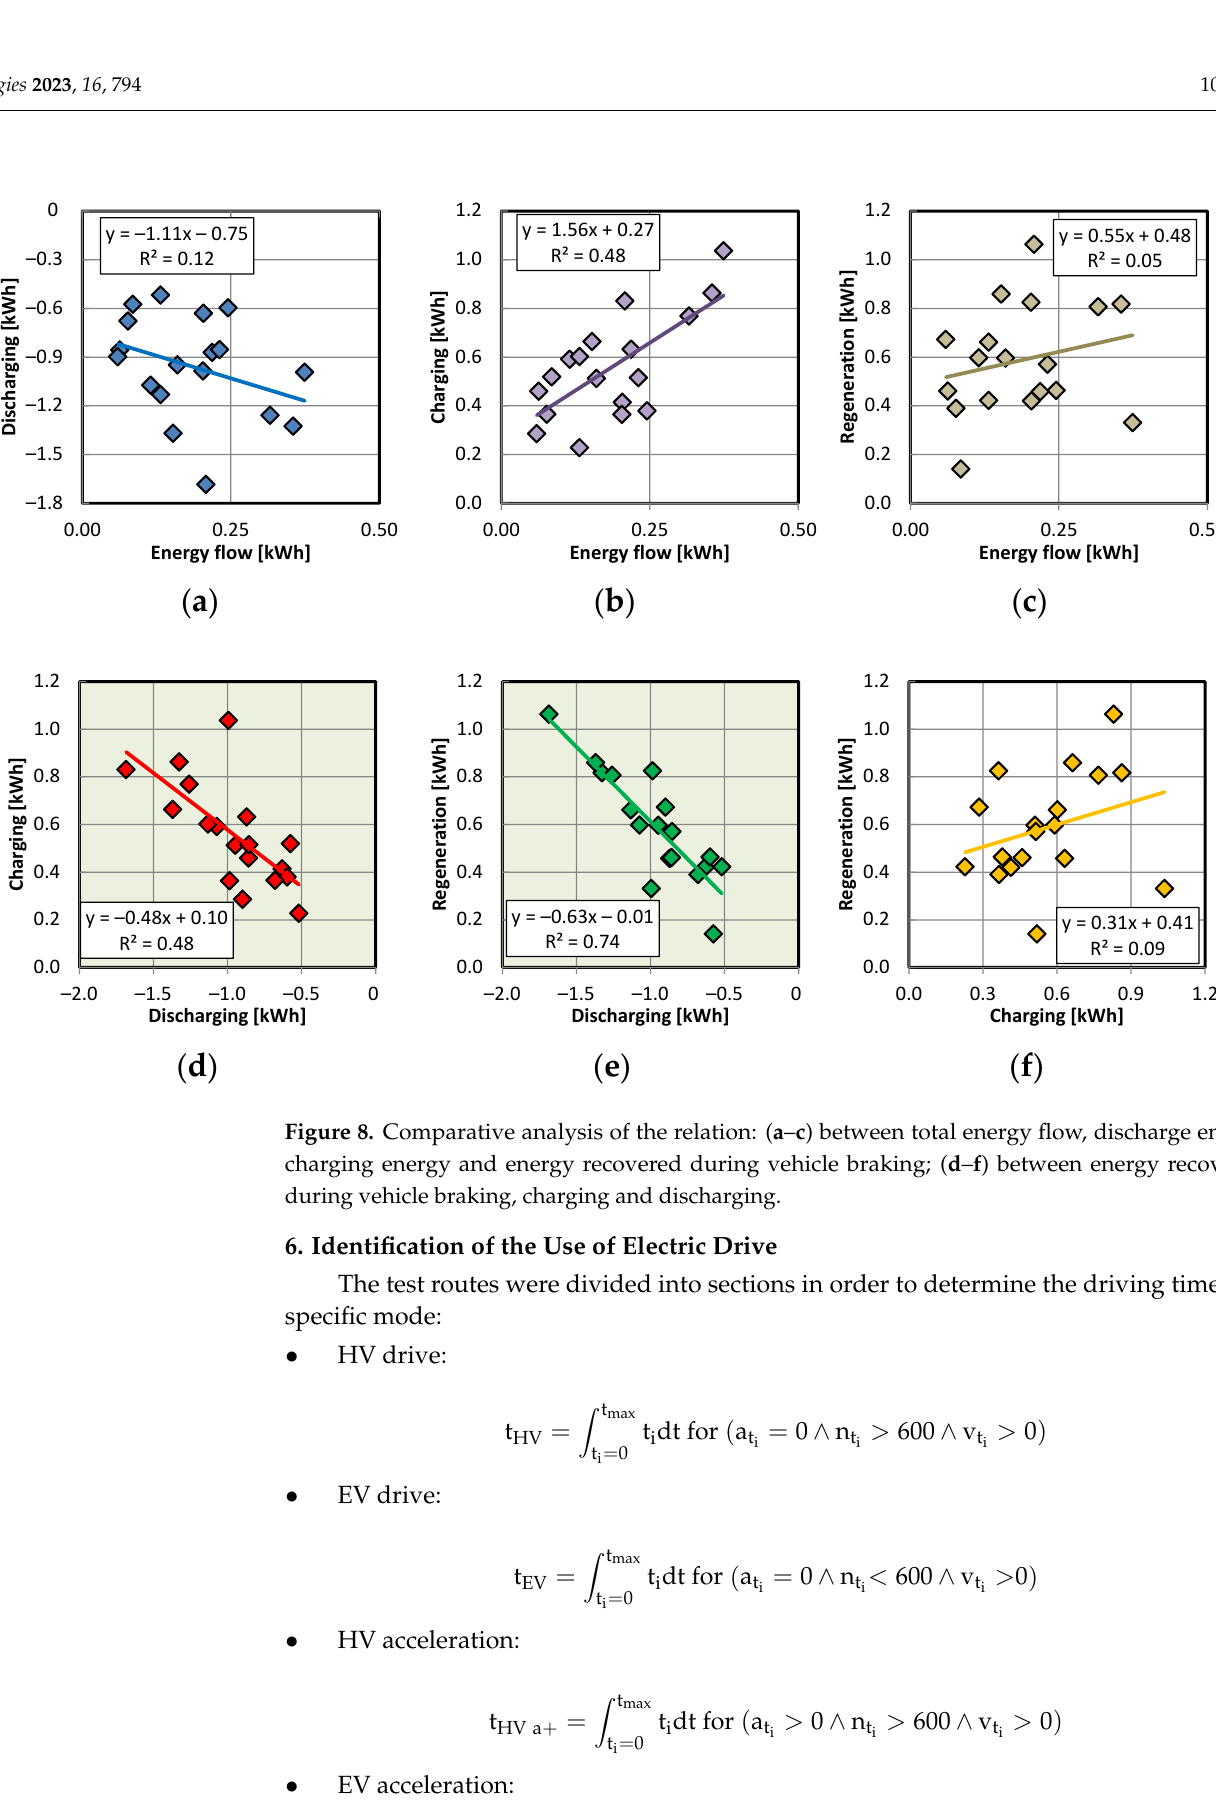
( d ) Figure 7. Analysis of energy flow in hybrid drives under urban driving conditions: ( a ) total energy flow (sum of discharging, charging and charging during regenerative braking); ( b ) discharge; ( c ) charging; ( d ) charging during regenerative braking. The operating conditions of the drivetrain as well as variable route conditions cause the values to contain varying values, but one might point to greater positive energy flows for vehicles with greater weight and dimensions; these are characterized by increased amounts of energy recovered during braking (noticeable for Toyota models C-HR, RAV4 and Lexus NX). These vehicles also experienced greater energy recovery during internal